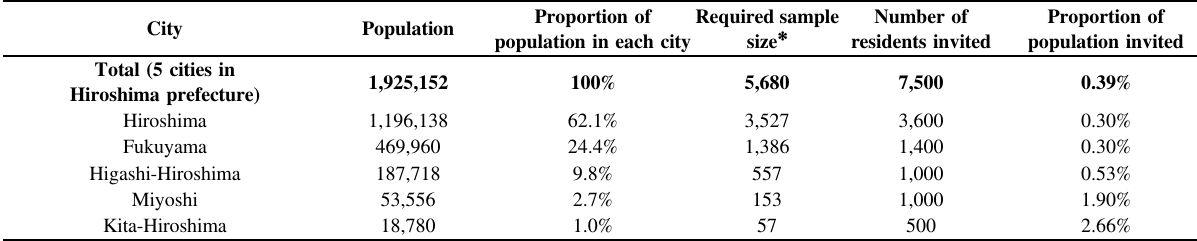
*Required total sample size was calculated assuming an antibody positivity rate of 0.20%, an absolute accuracy of 0.15%, and a participation rate of 60%. The required sample size for each city was determined by applying the required total sample size to the proportion of the population in each